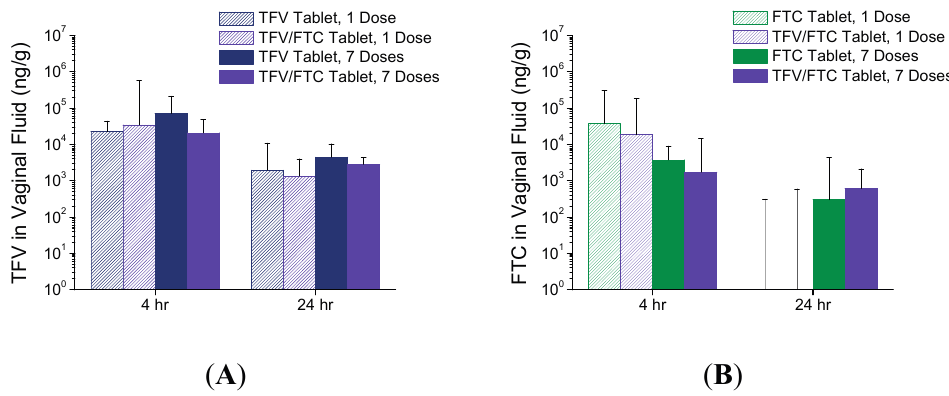
Figure 6. TFV ( A ); FTC ( B ); and TFV-DP ( C ) levels in cranial vaginal tissue